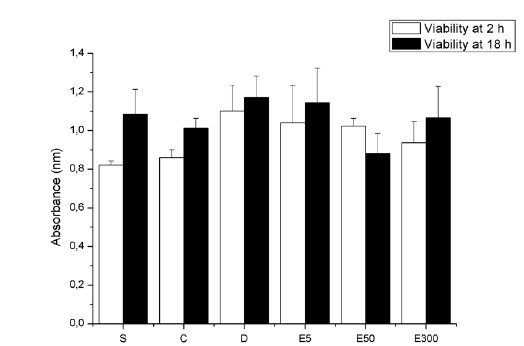
FIGURE 3 - Effect of the treatments on cell viability of rats’ peritoneal neutrophils. Cells were incubated for 2 and 18 h, and the viability was measured with MTT assay. Results are presented as means ± SD from two experiments performed in triplicate. S = saline group; C = carrageenan group; D = dexamethasone group; E5, E50 and E300 = extracts groups.